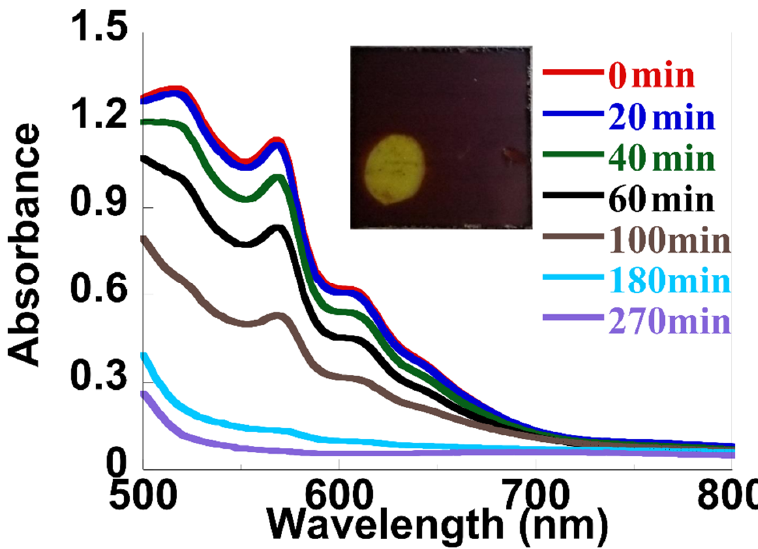
Figure 6. UV-vis spectra of the PEA 2 MA 2 Pb 3 I 10 film at various times, under continuous illumination using a 447-nm laser source at 350 mW/cm 2 in an ambient environment.